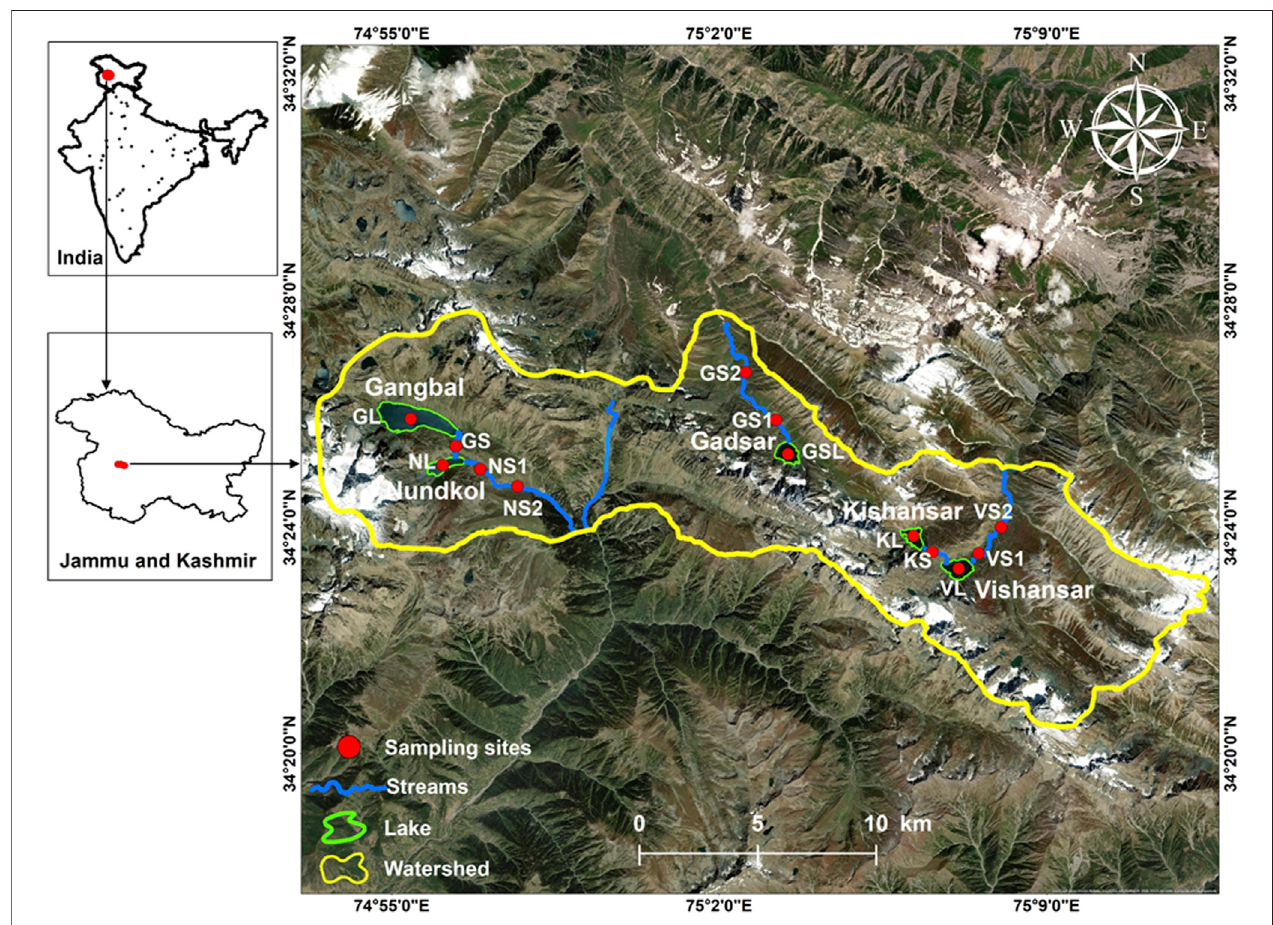
FIGURE 1 | Study area map showing some important alpine high altitude lakes in Kashmir Himalaya. Background image ESRI Basemap.